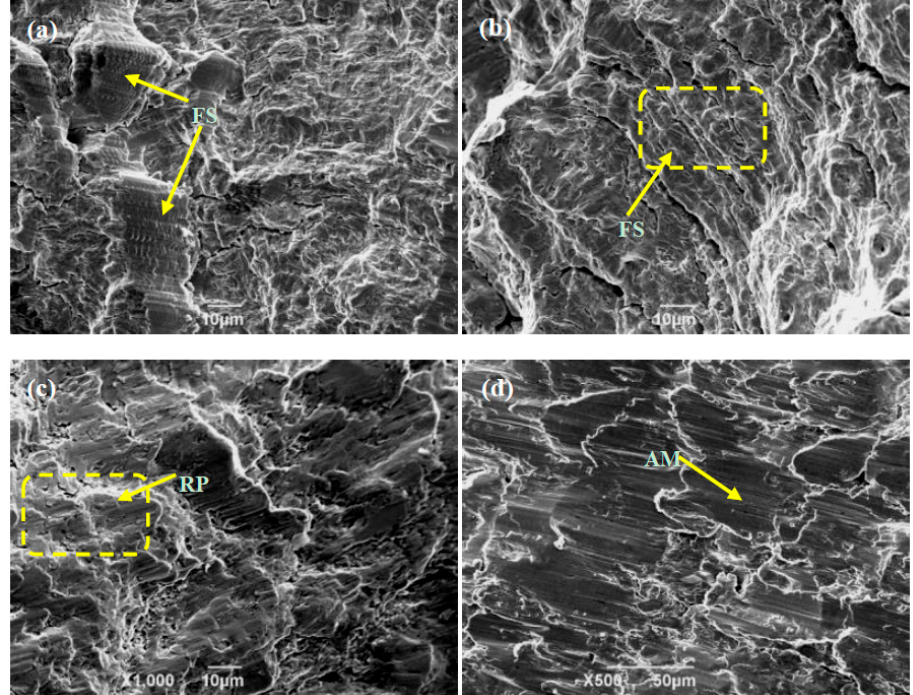
Figure 8. Fracture morphologies of fatigue crack propagation zone under proportional tension–torsion loading at different stress amplitudes. ( a ) S eq = 560.5 MPa, ( b ) S eq = 611.5 MPa, ( c ) S eq = 713.3 MPa, ( d ) S eq = 763 MPa. ‘FS’ represents fatigue striations, ‘RP’ represents river pattern, and ‘AM’ represents abrasion marks.